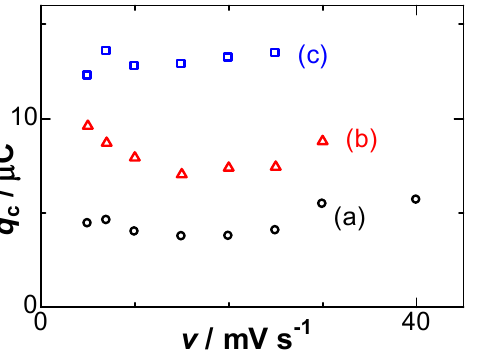
Figure 4. Variations of q c with the scan rates for the deposition times of ( a ) 40; ( b ) 70; ( c ) 100 s.